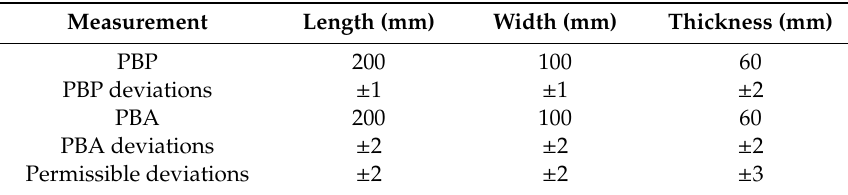
Table 3. Paving blocks measurements and deviations.